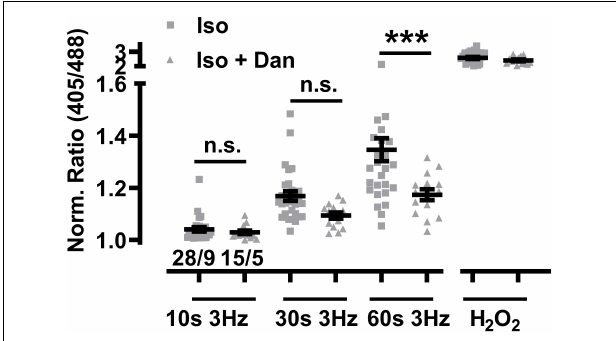
FIGURE 10 | Dantrolene diminishes mitochondrial oxidation in β -adrenergic stimulated RyR2-R2474S dTG cardiomyocytes. Dot plot showing the individual and mean ± SEM values of the normalized I405/I488 nm ratio recorded after 3 Hz beating for 10, 30, and 60 s in the presence of isoproterenol (100 nM) either with or without dantrolene pre-treatment (5 µ M for 2 h). Triangles and squares represent individual experiments ± dantrolene as given by the legend. Cell/heart numbers are indicated. Unpaired one-way ANOVA with Tukey’s post-test. *** P < 0.0002; n.s.,